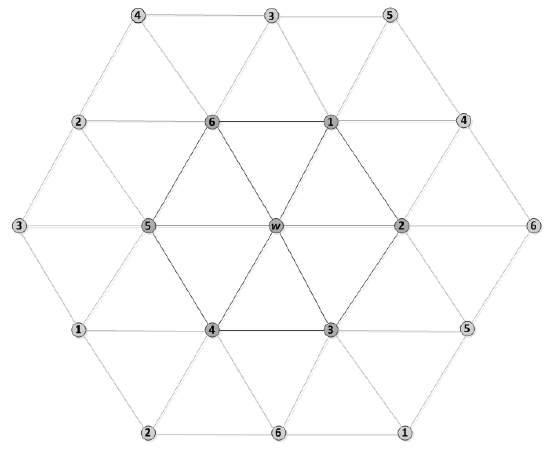
Figure 10. Network layout with two-hop neighbours of w